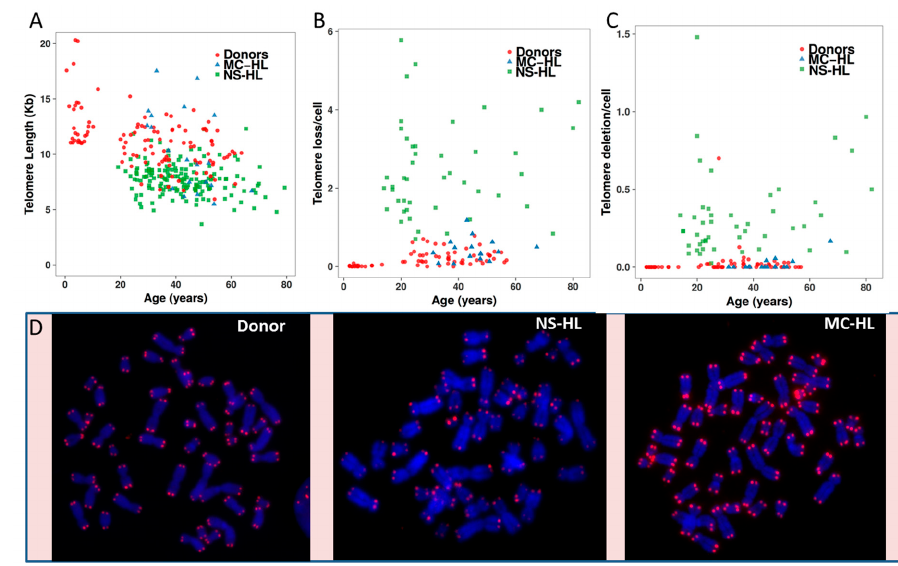
Figure 9. Telomere dysfunction in NS-HL (square green) and MC-HL patients (triangle blue) and healthy donors (circle red). ( A ) Telomere length (kb). ( B ) Telomere loss. ( C ) telomere deletions. ( D ) Representative image for a metaphase of a healthy donor, NS-HL patient, and MC-HL patient (63 × magnification).